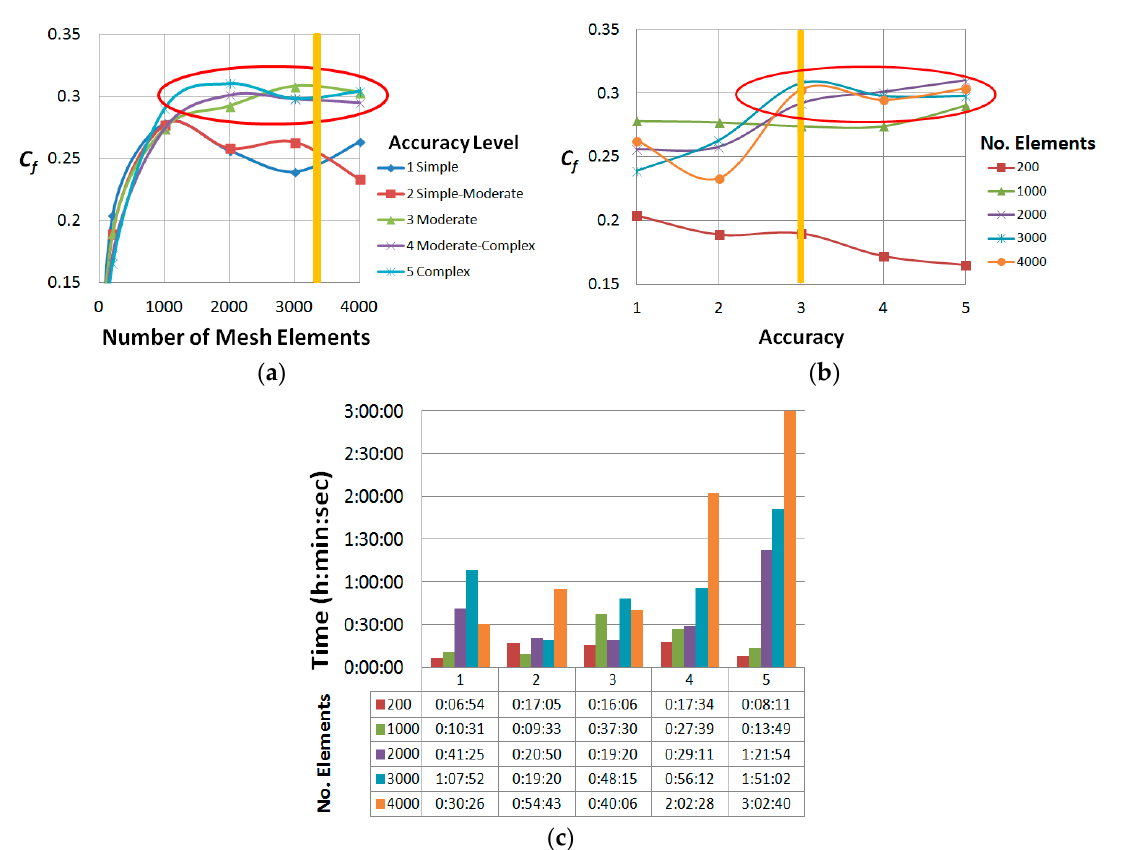
Figure 5. ( a ) Selection of number of elements of the mesh; ( b ) Selection of the accuracy level; ( c ) Computation times. ( c ) Computation